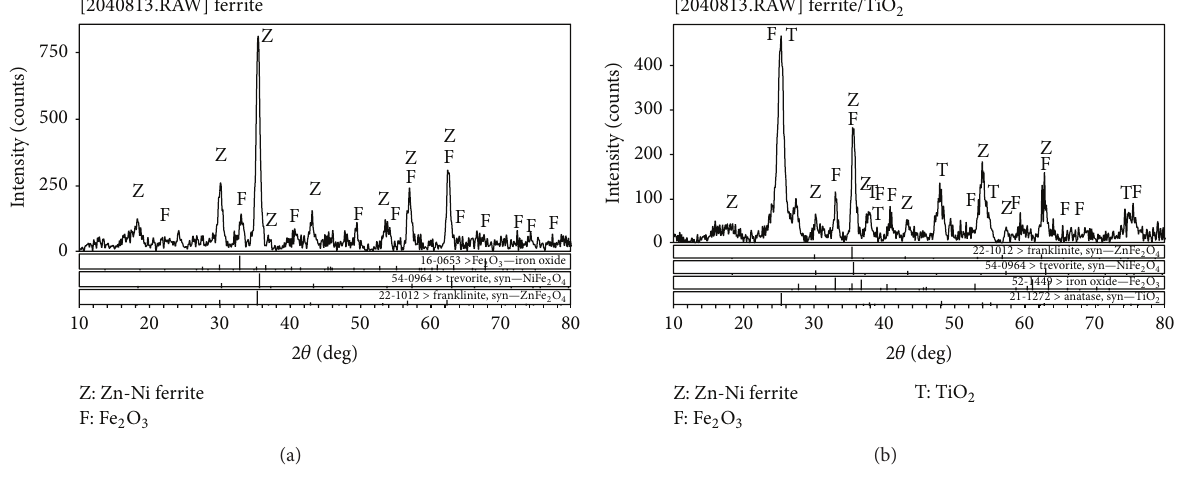
Figure 3: XRD diagram of Ni-Zn ferrite powder (a) and Ni-Zn ferrite/TiO 2 (500 ∘ C) (b).